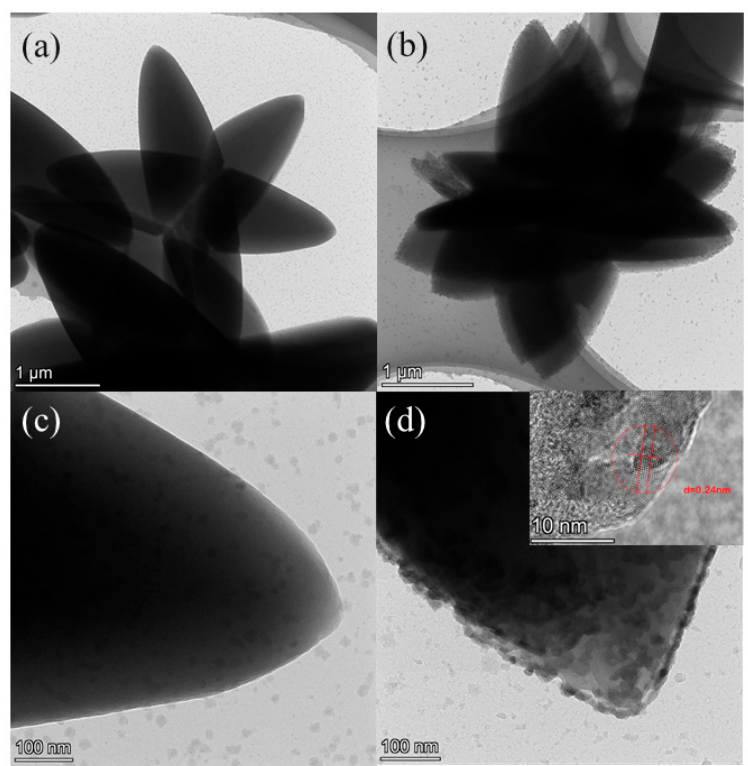
Figure 1. TEM images of ZIF-L ( a , c ) and the NCDs@ZIF-L composites ( b , d ) at a scale of 1 µ m and 100 nm. The inset image shows HR-TEM result.